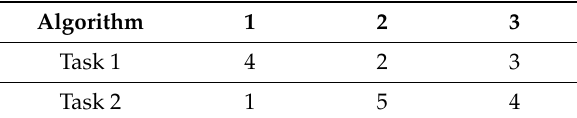
Figure 3. Convergence of the discrepancy of estimates of the transport table . Analyzing the plot of convergence of the residual, it becomes clear that even an insignificant error by the decision maker in measurements of target preferences (elements of transport tables) leads to fairly rapid machine learning of the transport model. Even the proposed algorithm for the machine learning model leads to a rapid convergence of estimates. This is shown by the simulation studies of the generalized adaptation of the payment matrix algorithm of the transport model (transport table) to the real preferences of the decision maker. We tested our approach experimentally on the Thomson Reuters dataset which contained 851 records and nine numeric attributes including the target one. We chose this smaller dataset because of our data transformation (with a 15-fold repetition of experiments in order to make them more representative), which took a long time to compute. We used a feedforward machine learning approach with one hidden layer and a sigmoid activation function. Table 2 shows some prediction examples for this dataset as well as the corresponding threshold-crossing probabilities and 90 percent tolerance intervals. Approach of heterogeneous group of algorithms is below: Input: Dataset D = {(x1 , y1),(x2, y2), . . . ,(xm, ym)}; First-level learning algorithms L1 , L2, . . . , Ln; Second-level learning algorithm L; Process: %Train a first-level individual learner ht by applying the first-level learning algorithm Lt to the original dataset D for t = 1, . . . , T: ht = Lt(D) end; % generate a new data set D0 = φ ; for i = 1, . . . , m: for t = 1, . . . , T: zit = hi (xi ) % Use ht to predict training example xi end; D0 = D0 ∪ {((zI1 , zi2 , . . . , zT), yi )}